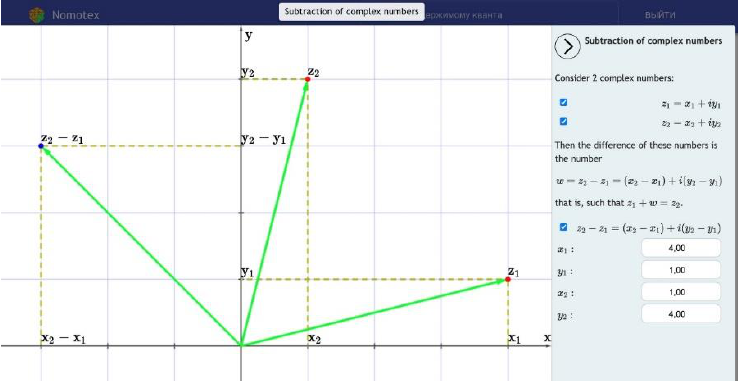
Fig. 2. Example of visualization in DLS